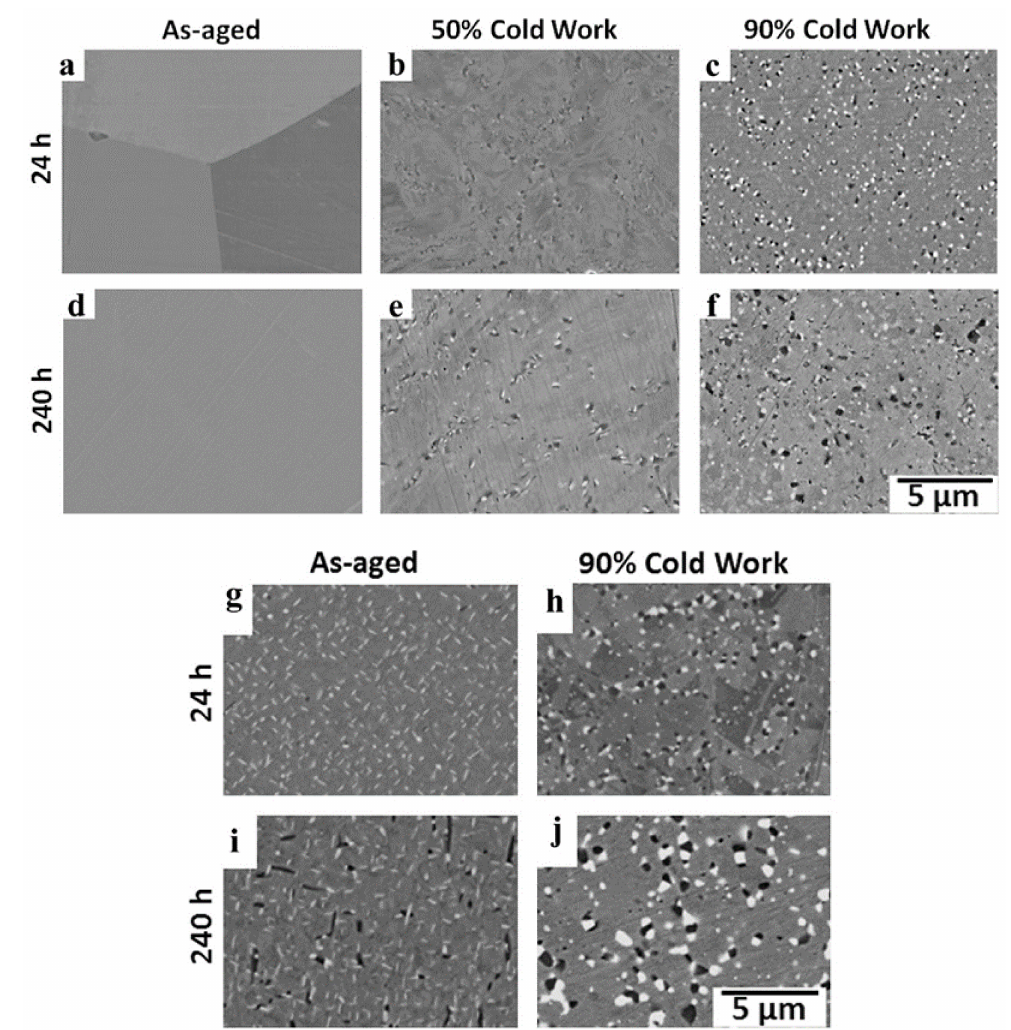
Figure 7. Backscattered electron images from specimens: ( a ) 24 h aged at 700 ◦ C; ( b ) 24 h after 50% cold work aged at 700 ◦ C; ( c ) 24 h after 90% cold work aged at 700 ◦ C; ( d ) 240 h aged at 700 ◦ C; ( e ) 240 h after 50% cold work aged at 700 ◦ C; ( f ) 240 h after 90% cold work aged at 700 ◦ C; ( g ) 24 h aged at 800 ◦ C; ( h ) 24 h after 90% cold work aged at 800 ◦ C; ( i ) 240 h aged at 800 ◦ C; and ( j ) 240 h after 90% cold work aged at 800 ◦ C